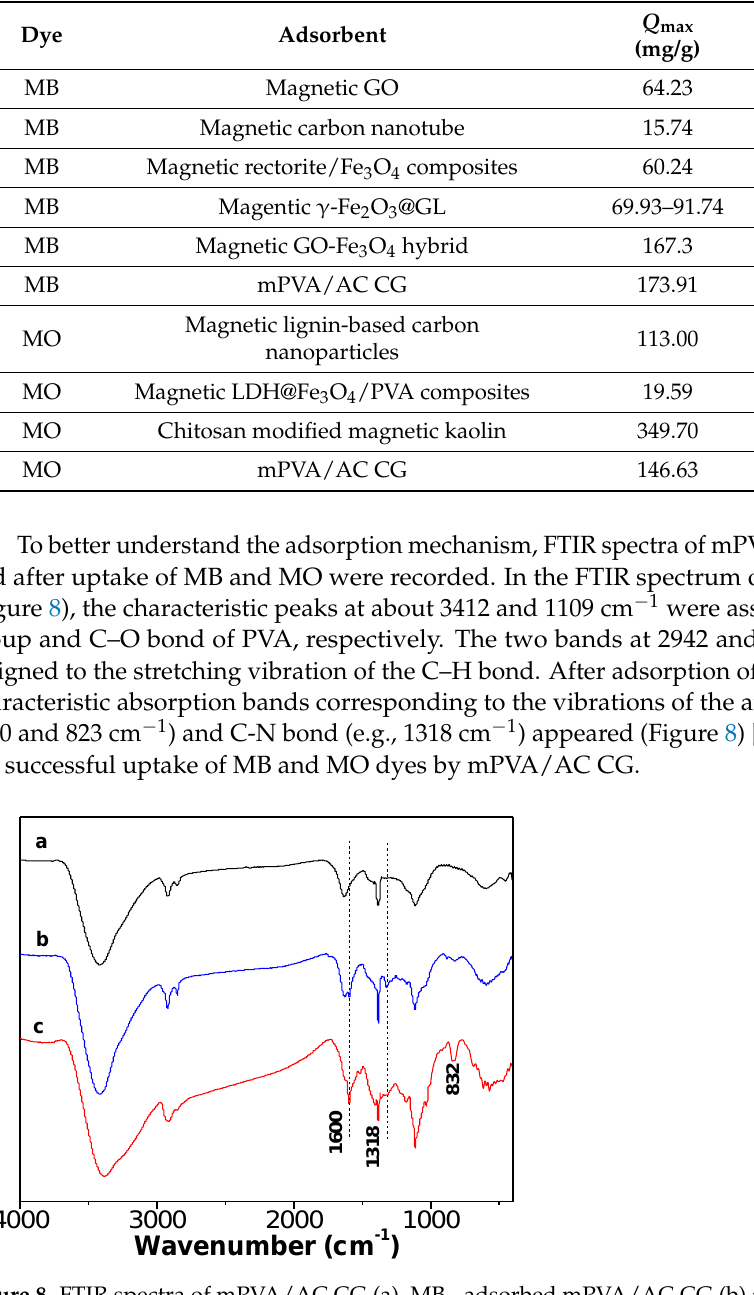
Table 4. Comparison of the maximum monolayer adsorption of MB and MO onto various mag- netic adsorbents.